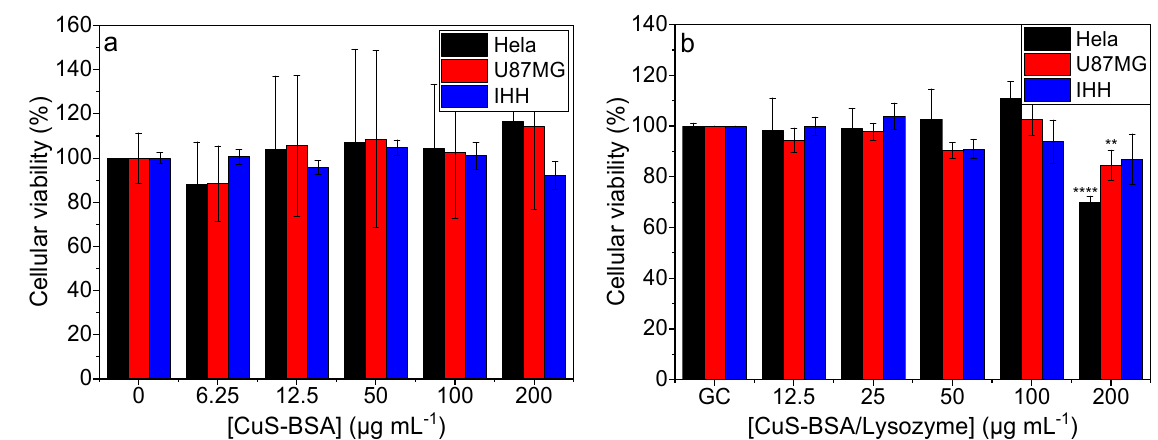
Figure 5. Cellular viability of ( a ) CuS-BSA and ( b ) CuS-BSA/lysozyme at various concentrations (0–200 µg mL − 1 ) without irradiation on different cell lines. ** p < 0.01, **** p < 0.0001.